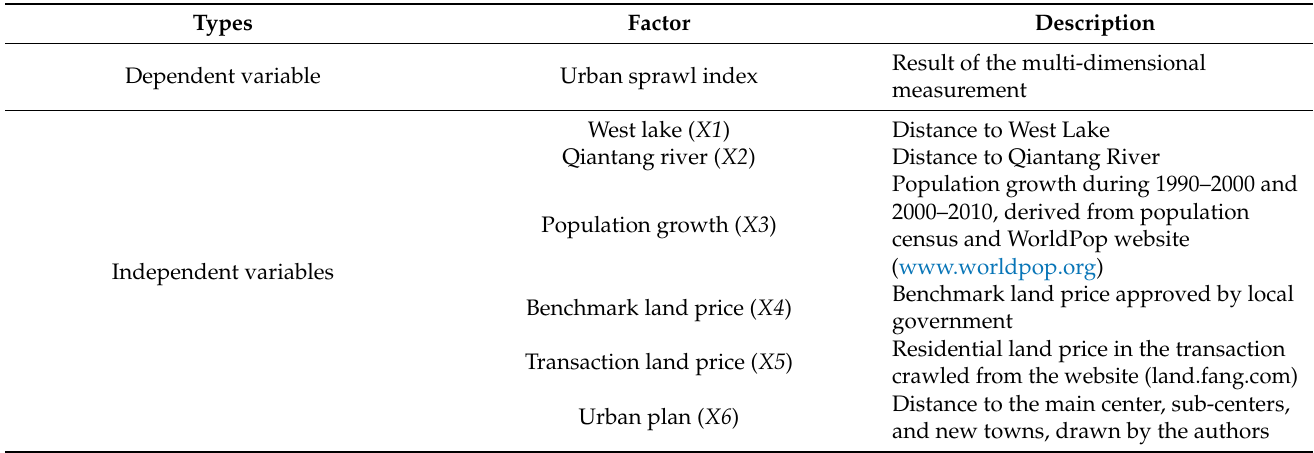
Table 3. Variables for GeoDetector modeling.